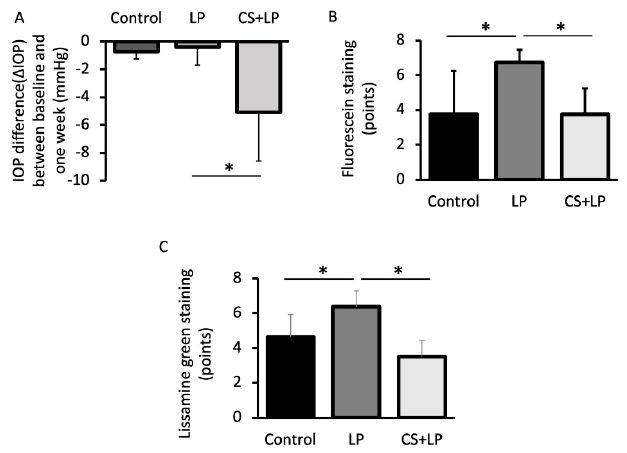
Figure 2. Comparison of the intraocular pressure difference and vital staining scores at one